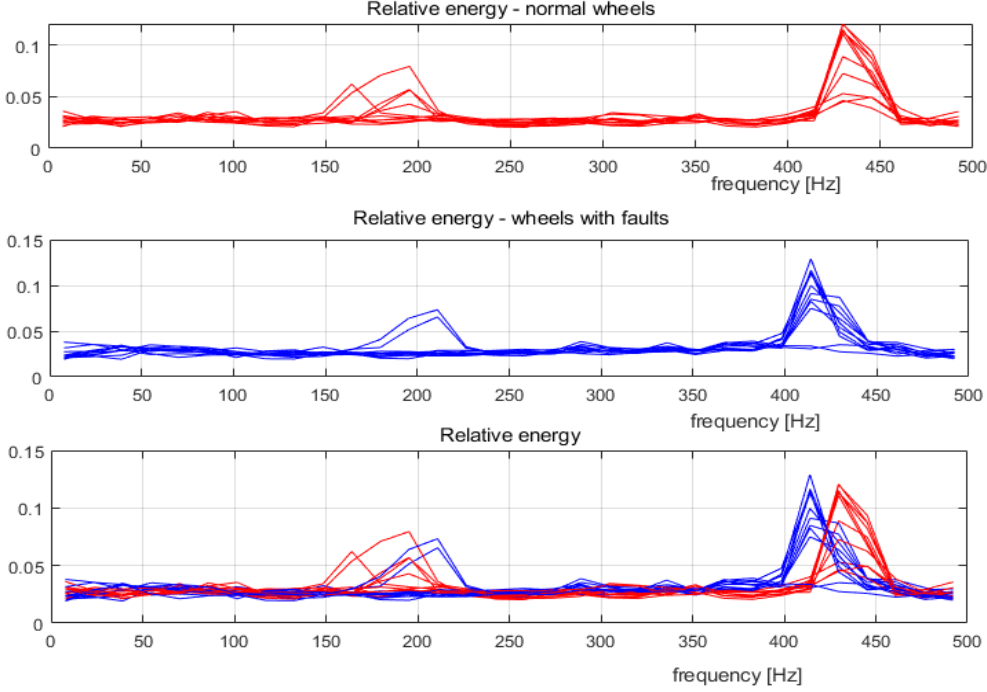
Figure 2. Relative energy of the sensor samples (red lines: relative energy of normal wheels; blue lines: relative energy of faulty wheels).